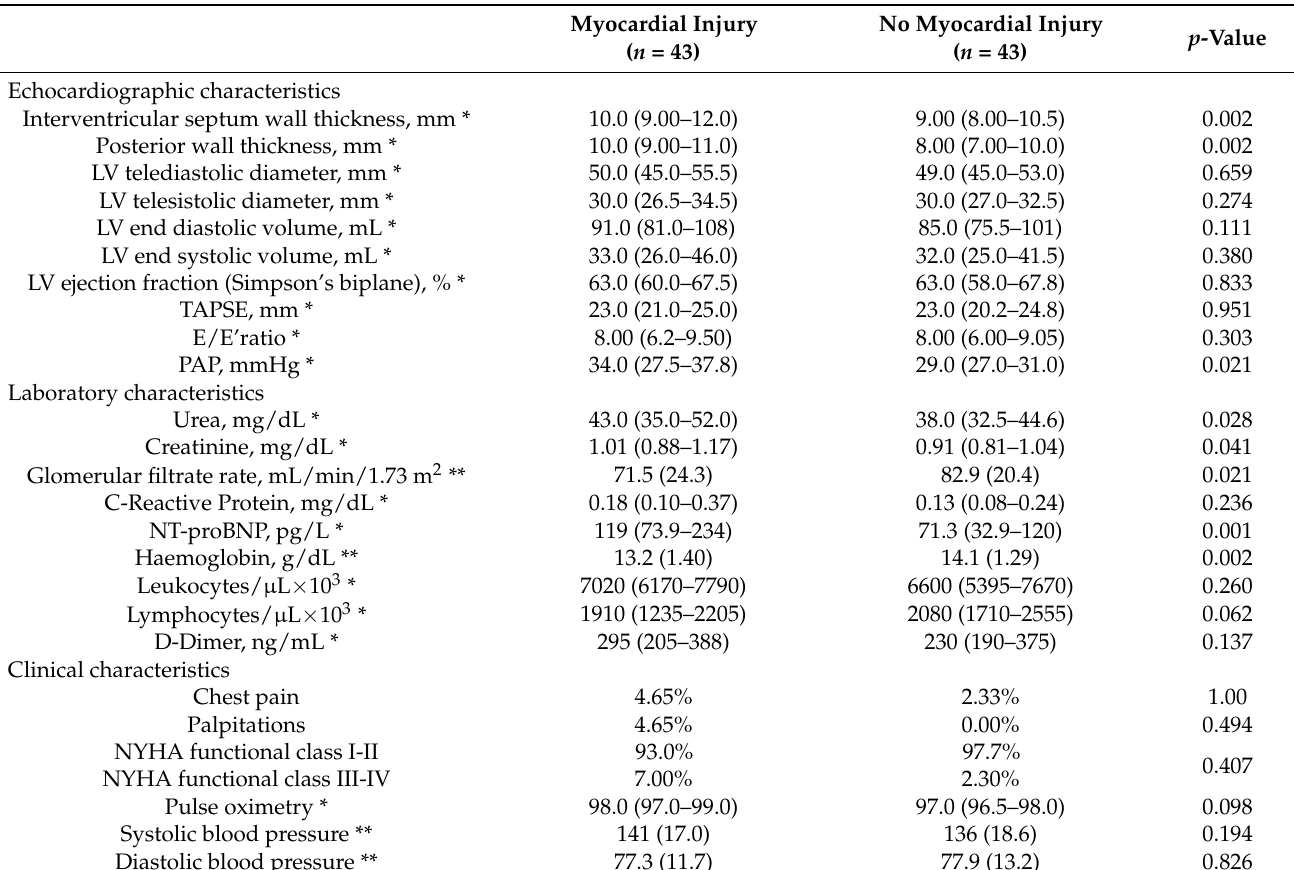
Table 3. Echocardiographic, laboratory and clinical characteristics of COVID-19 patients at six months after initial hospital